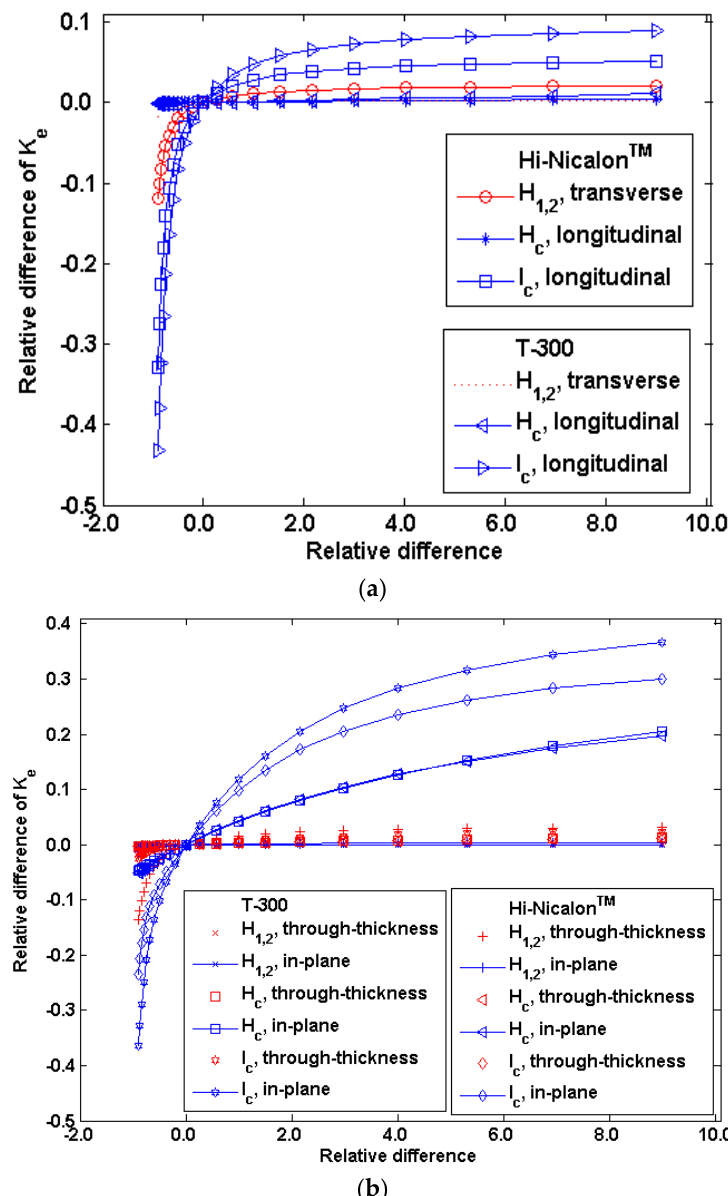
Figure 11. The sensitivity of theeffective thermal conductivity to the matrix cracking parameters H 1,2 , H c and l c : ( a ) 1D and ( b ) 2D composites.